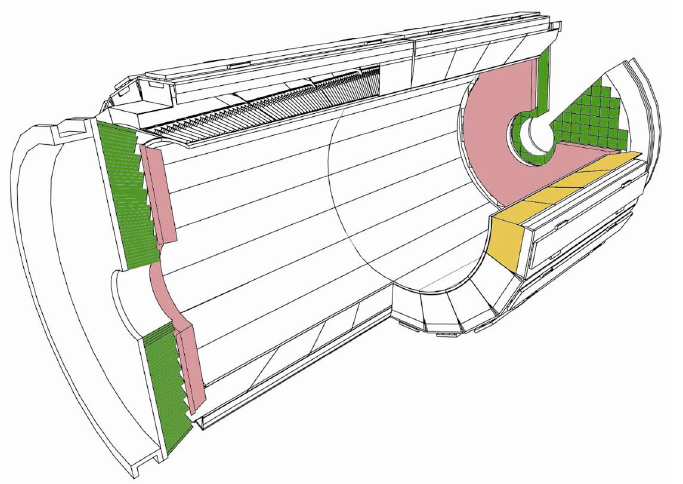
Figure 1. Layout of the CMS ECAL. One of the 36 barrel supermodules is highlighted in yellow, and the endcaps are highlighted in